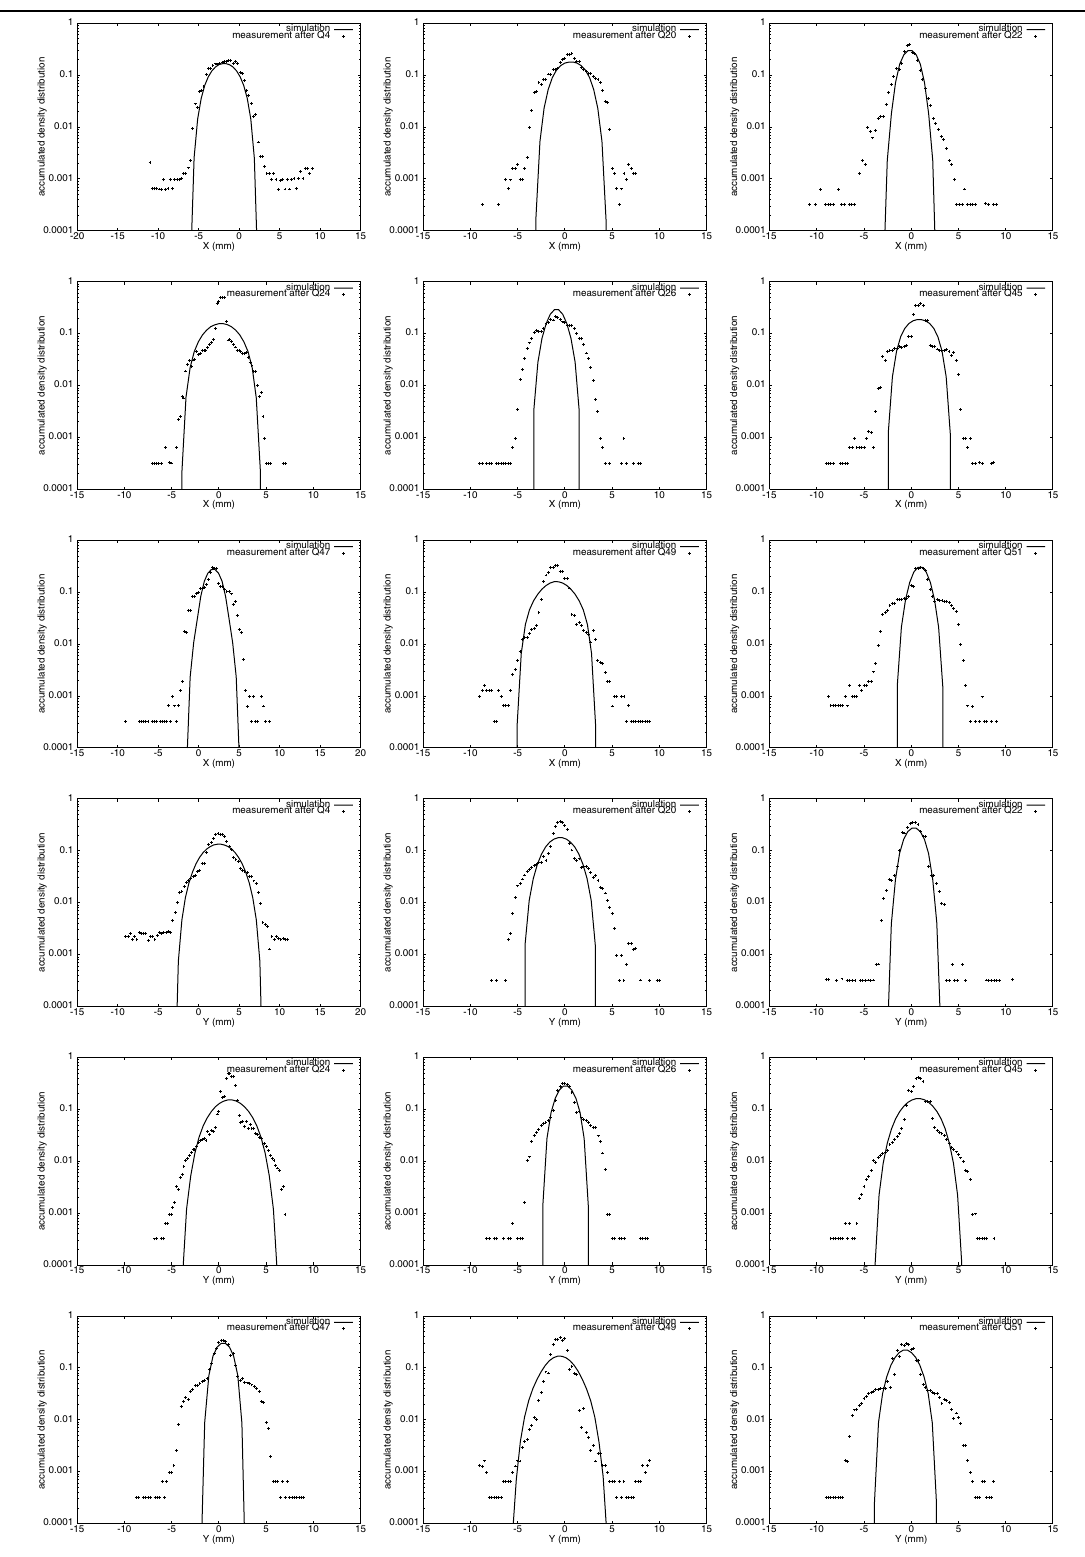
FIG. 7. X and y density distribution from simulation using initial Waterbag distribution and from measurements at 75 mA and mismatch factor of 1.5. The first nine plots correspond to the nine x profiles and the second nine plots correspond to the nine y